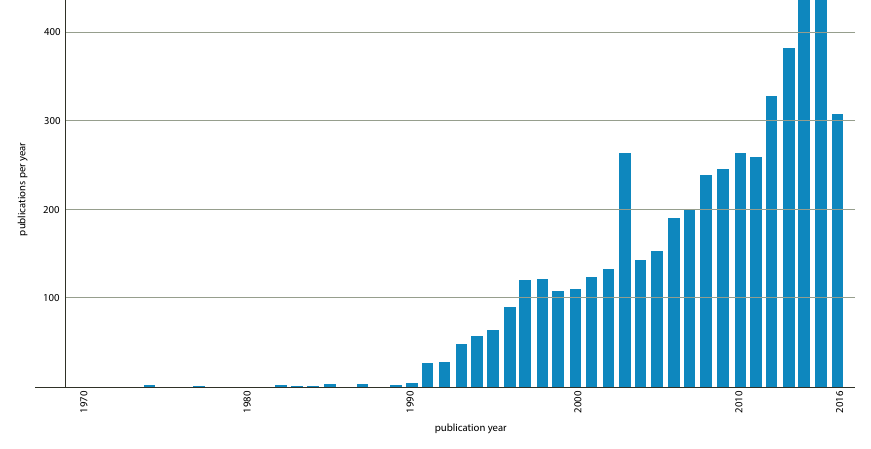
Figure 4. Published Articles for Predictive Maintenance